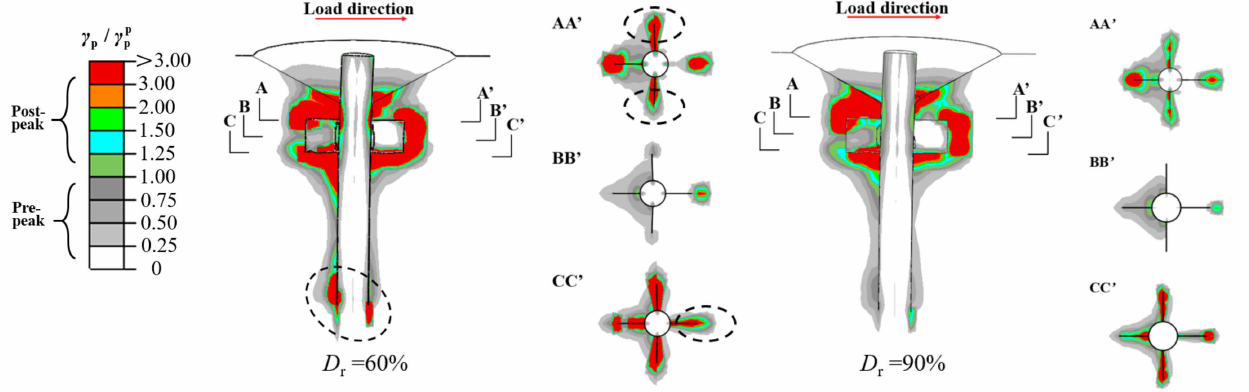
Figure 17. Distribution of plastic shear strain in the plane of symmetry of the winged monopile with different relative densities ( D r ) at θ = 2 ◦